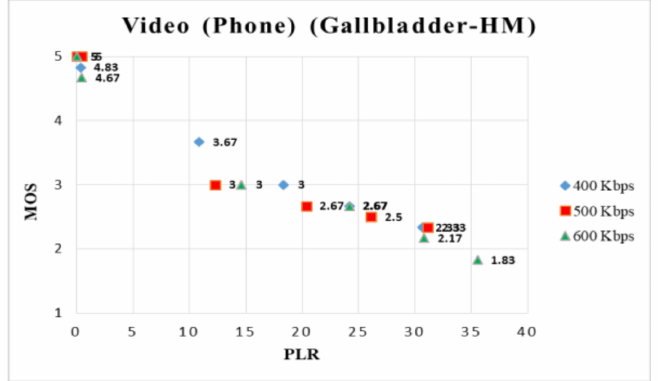
Figure 13. MOS ratings for stomach ultrasound (MM) on